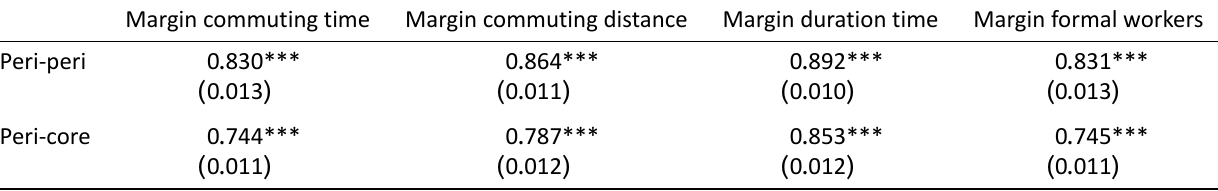
Table 8. Margins of transportation mode choices of